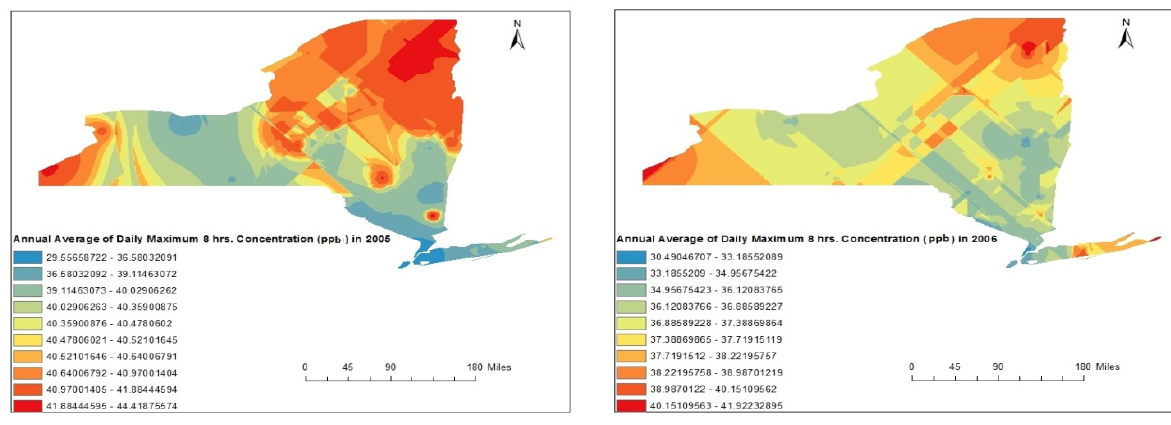
Figure 5. (a – c ) Spatial distribution of annual average maximum daily eight hours ozone concentrations during 2005 to